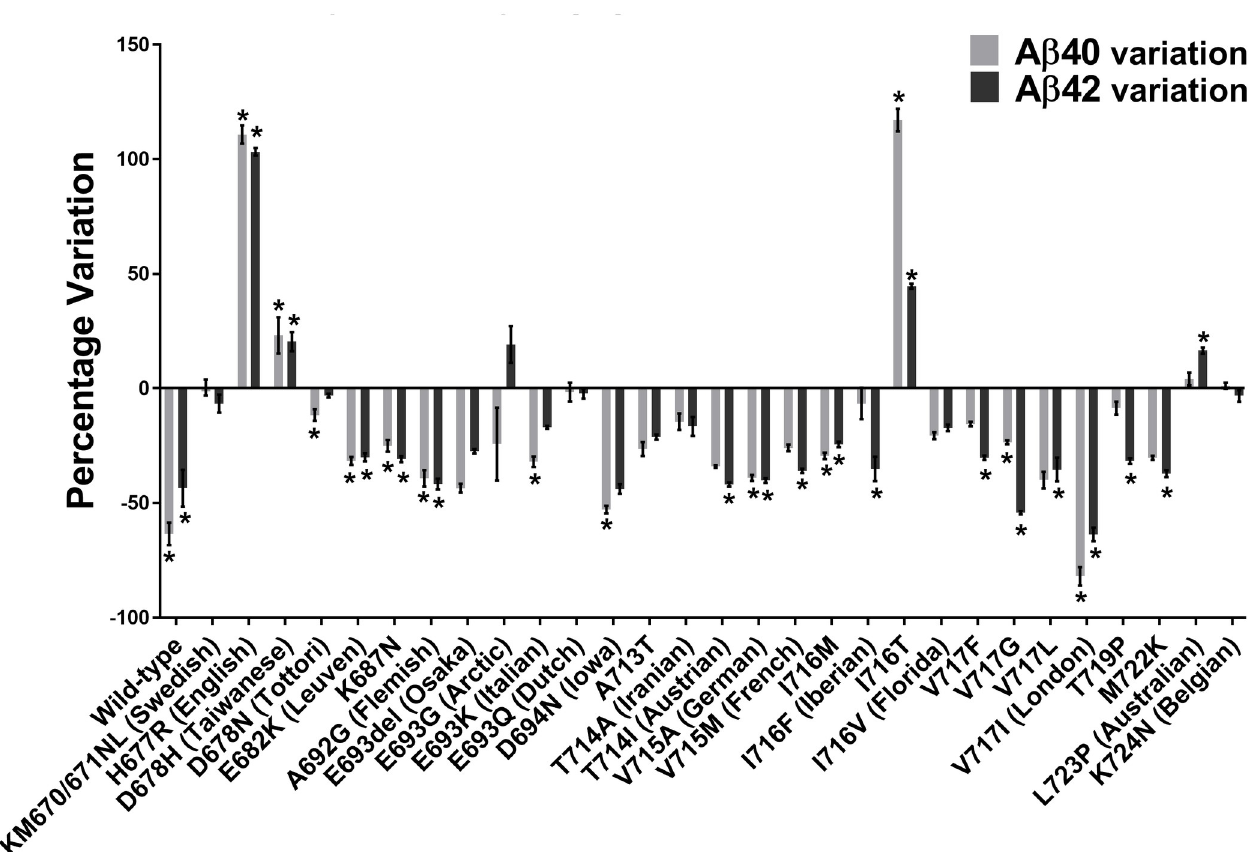
Fig 4. Variations of A β 40 and A β 42 peptide concentrations with A673T mutation. Percentage changes of A β 40 and A β 42 peptide concentrations induced by the addition of the A673T mutation to plasmids containing or not an FAD mutation. � indicates this variation was statistically significant with the two-way ANOVA Sidak’s multiple comparisons